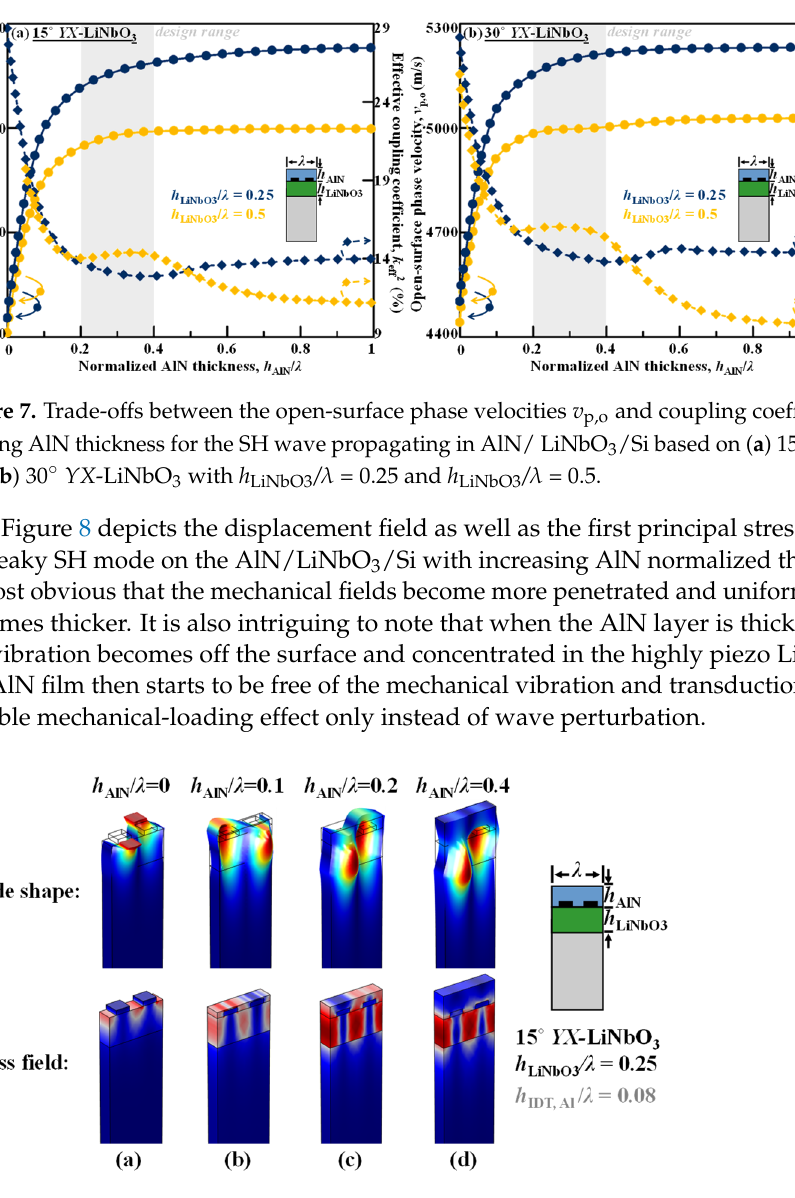
Figure 8. FEM-simulated mode shapes and the first principal stress field of the nonleaky SH mode on the AlN/LiNbO 3 /Si substrate stack with ( a ) h AlN / λ = 0, ( b ) h AlN / λ = 0.1, ( c ) h AlN / λ = 0.2, and ( d ) h AlN / λ =